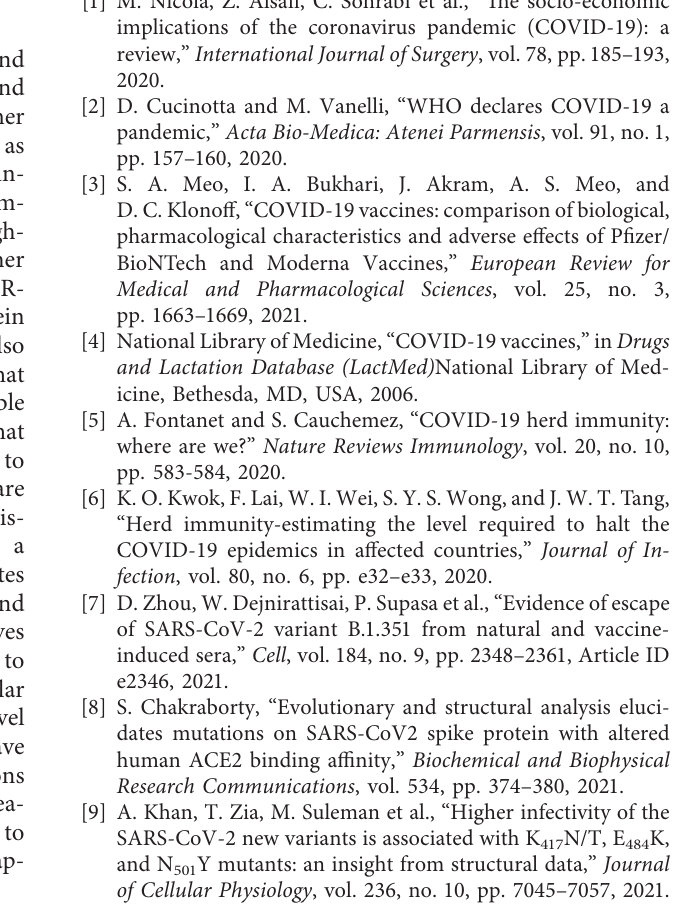
Figure S1: titration of biotin-tagged ACE2 against a fixed concentration of 6xHis-tagged S1 RBD (left). Maximal value was obtained at the hook point before diminishing in signal.